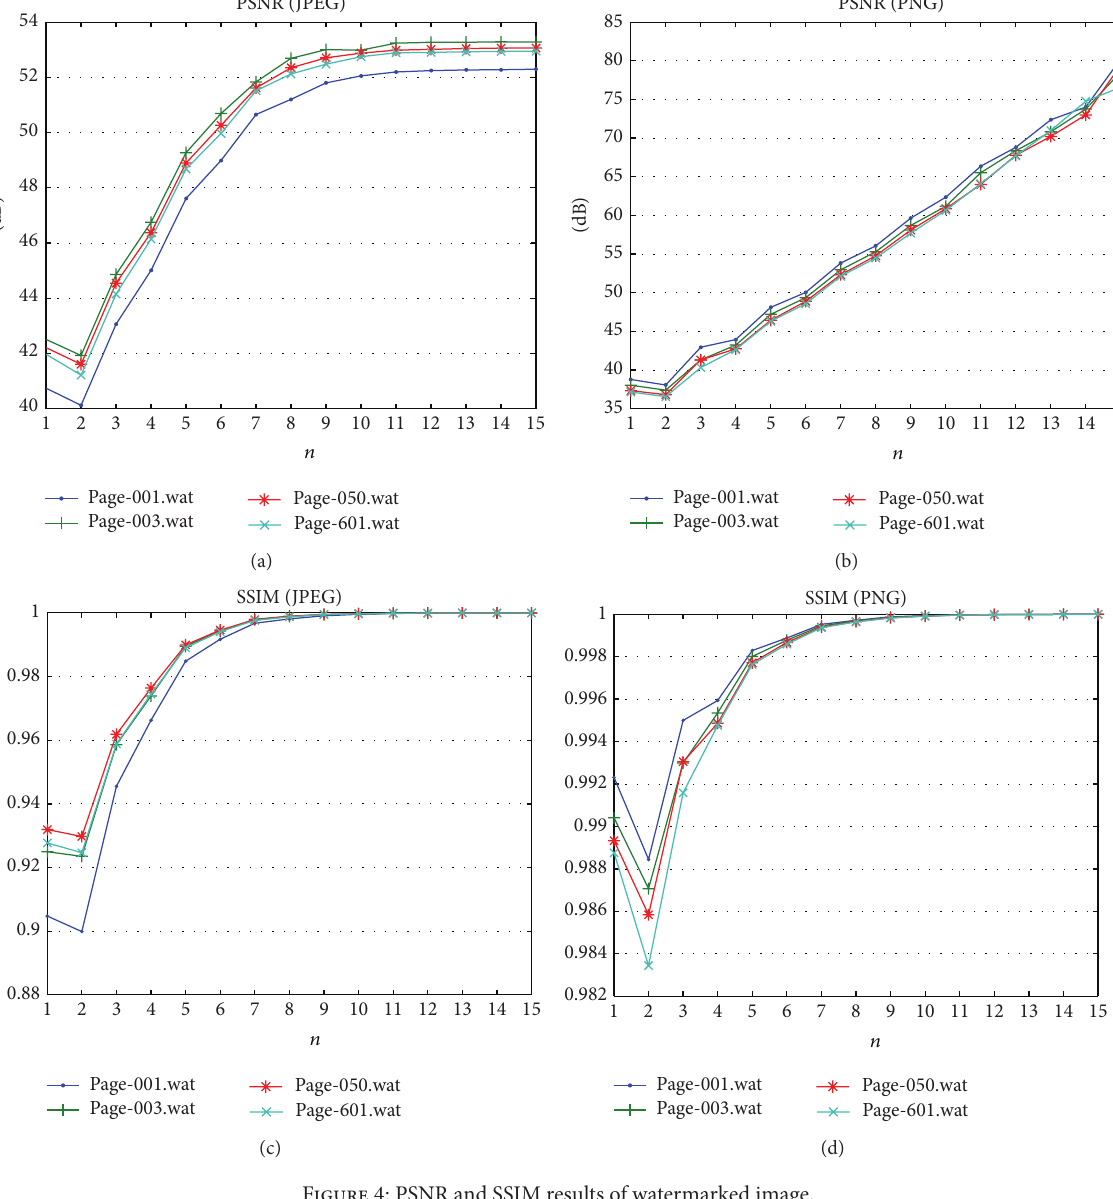
Figure 4: PSNR and SSIM results of watermarked